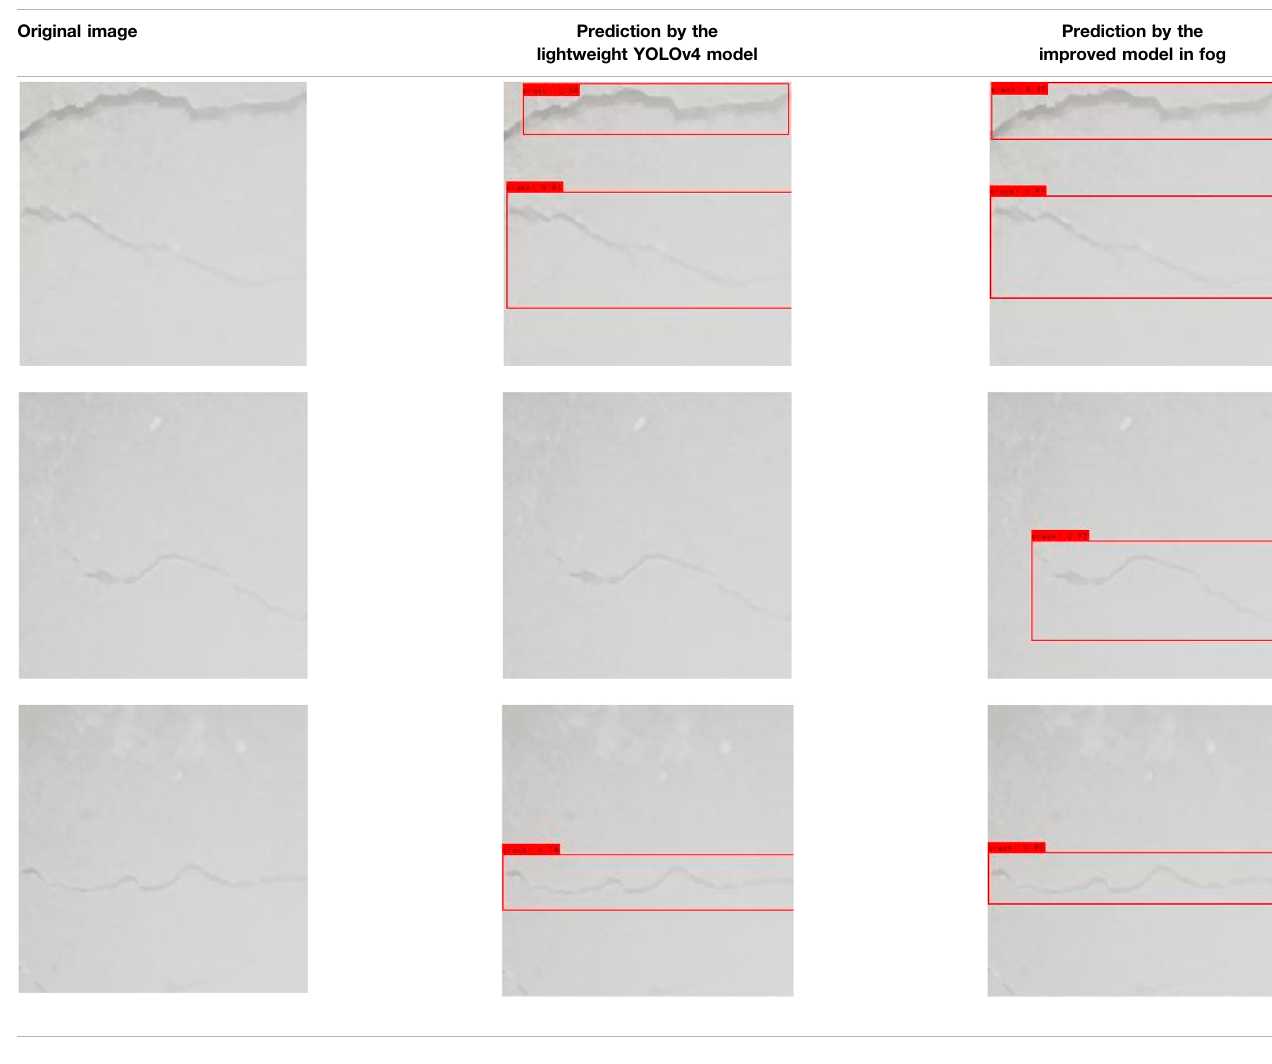
TABLE 6 | The input and output of the lightweight YOLOv4 model and the improved model in fog in concrete surface crack